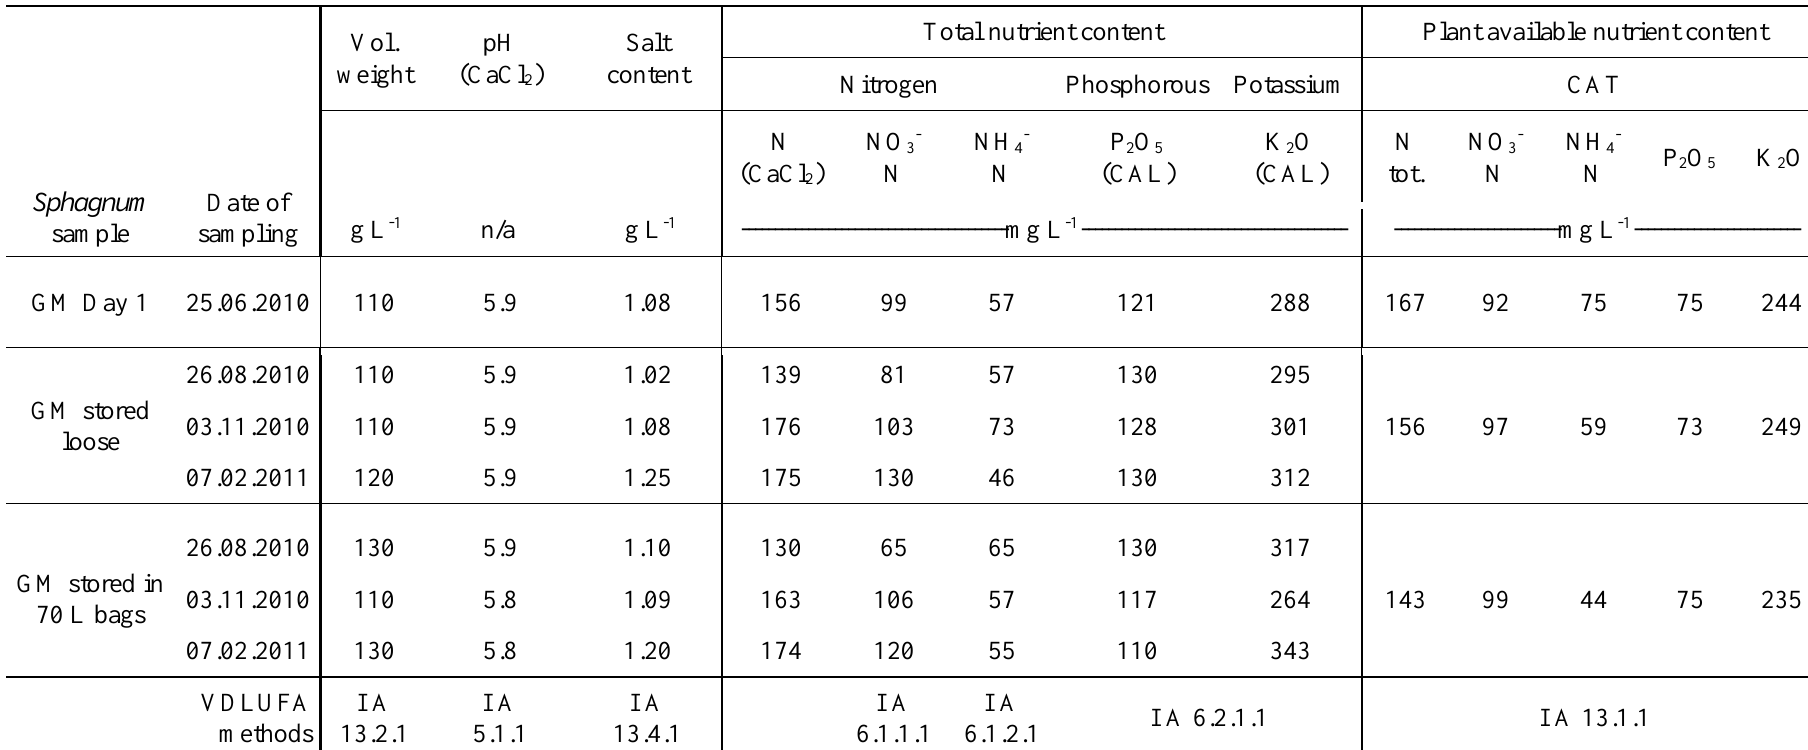
Table 3. Nutrient levels, pH and salt content for a Sphagnum based growing medium ( Sphagnum GM) over a storage period of seven months following the VDLUFA extraction procedures (VDLUFA